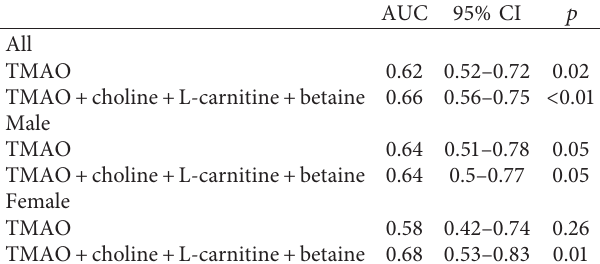
Table 5: AUC of TMAO, choline, L-carnitine, and betaine for predicting severe artery stenosis in all, male, and female